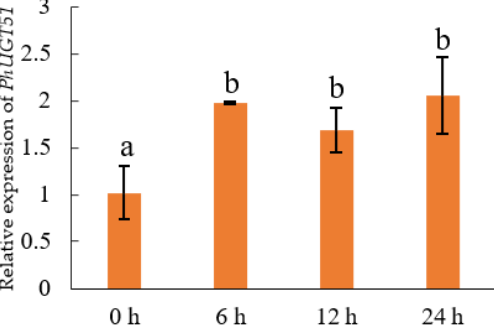
Figure 6. Quantitative real-time PCR (qRT-PCR) analysis of PhUGT51 after various NaCl treatment periods. Lowercase letters indicate significant differences.